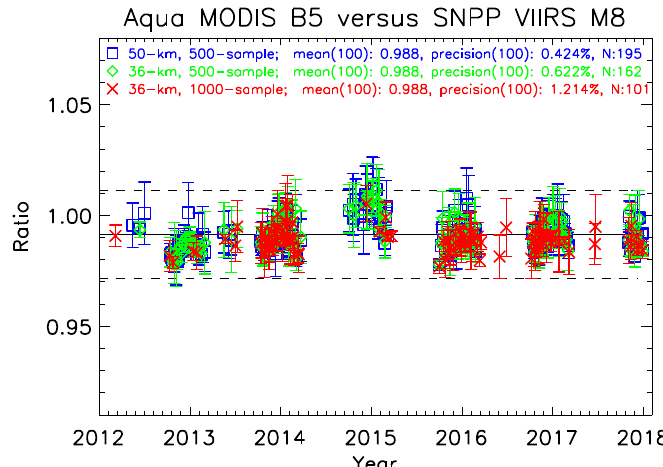
Figure 9. The time series of Aqua MODIS B5 versus SNPP VIIRS M8 under three combinations of area scale and sample size. A 3% precision threshold is imposed on each SNO event.